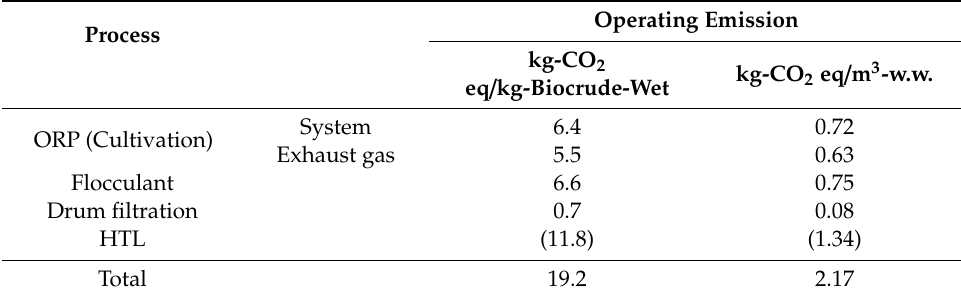
Table 10. Emission from algal fuel production.